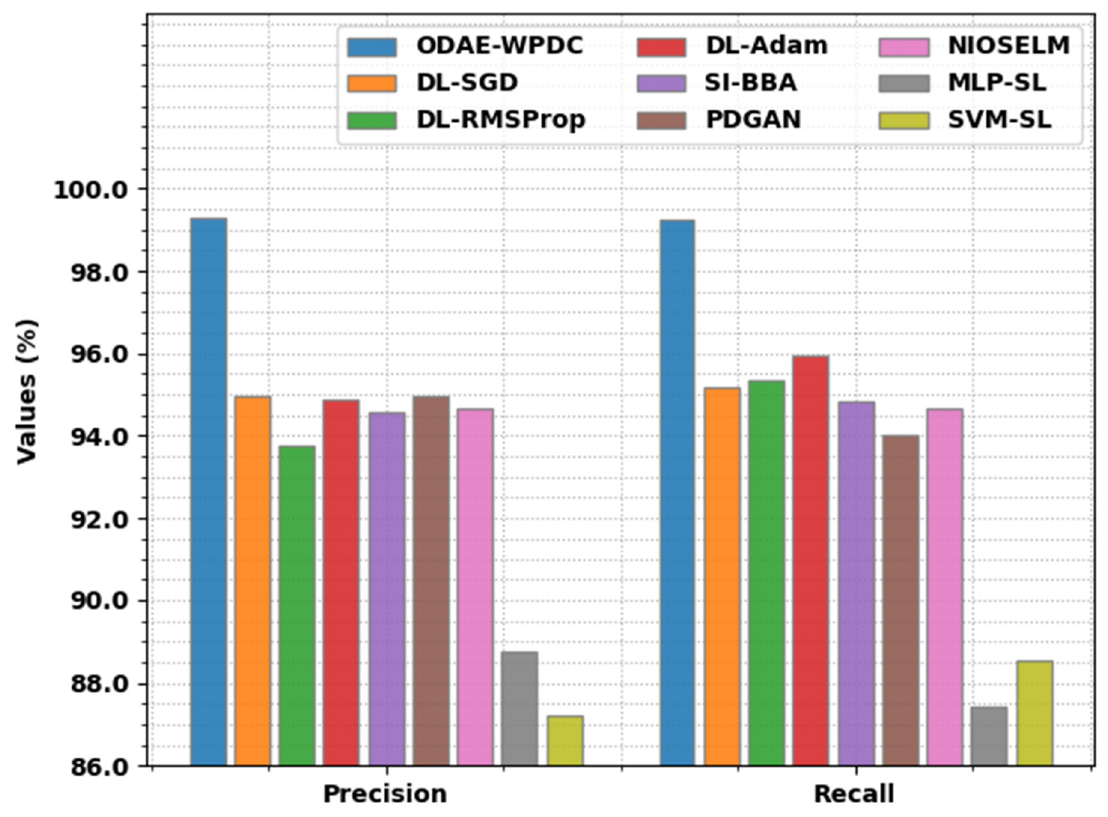
Figure 8. Prec n and reca l analysis of ODAE-WPDC approach with existing Figure 8. 𝑃𝑟𝑒𝑐 (cid:3041) and 𝑟𝑒𝑐𝑎 (cid:3039) analysis of ODAE ‐ WPDC approach with existing methodologies Figure 9 showcases a comparative 𝑎𝑐𝑐𝑢 (cid:3052) and 𝐹 (cid:3046)(cid:3030)(cid:3042)(cid:3045)(cid:3032) examination of the ODAE ‐ WPDC methodology with recent techniques. The figure exposes that the ODAE ‐ WPDC system has resulted in enhanced performance with regard to 𝑎𝑐𝑐𝑢 (cid:3052) and 𝐹 (cid:3046)(cid:3030)(cid:3042)(cid:3045)(cid:3032) . Interms of 𝑎𝑐𝑐𝑢 (cid:3052) , the ODAE ‐ WPDC system has obtained enhanced 𝑎𝑐𝑐𝑢 (cid:3052) of 99.28%, whereas the DL ‐ SGD, DL ‐ RMSProp, DL ‐ Adam, SI ‐ BBA, PDGAN, and NIOSELM algorithms have reached 𝑎𝑐𝑐𝑢 (cid:3052) of 94.64%, 92.84%, 94.69%, 94.93%, 94.12%, and 93.40%, correspondingly. With regard to 𝐹 (cid:3046)(cid:3030)(cid:3042)(cid:3045)(cid:3032) , the ODAE ‐ WPDC system has obtained higher 𝐹 (cid:3046)(cid:3030)(cid:3042)(cid:3045)(cid:3032) of 99.27%, whereas the DL ‐ SGD, DL ‐ RMSProp, DL ‐ Adam, SI ‐ BBA, PDGAN, and NIOSELM systems have reached 𝐹 (cid:3046)(cid:3030)(cid:3042)(cid:3045)(cid:3032) of 94.50%, 95.52%, 95.27%, 94.78%, 92.21%, and 90.86%, correspond ‐ ingly.